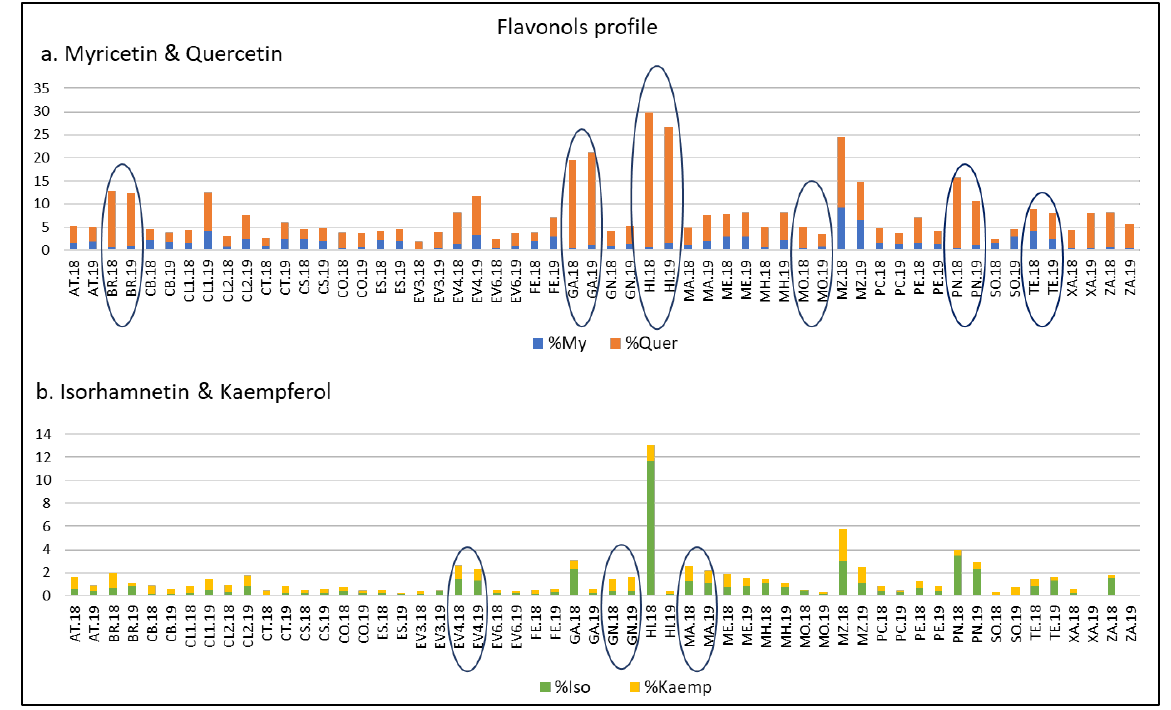
Figure 2. Flavonols profile with respect to the total polyphenolic content of varieties from the EVEGA germplasm bank in 2018 and 2019 vintages. % MY: percentage of myricetin compounds; % Quer: percentage of quercetin compounds; % Iso: percentage of isorhamnetin compounds; % Kaemp: percentage of kaempherol compounds. See Table 1 for varieties abbreviations.